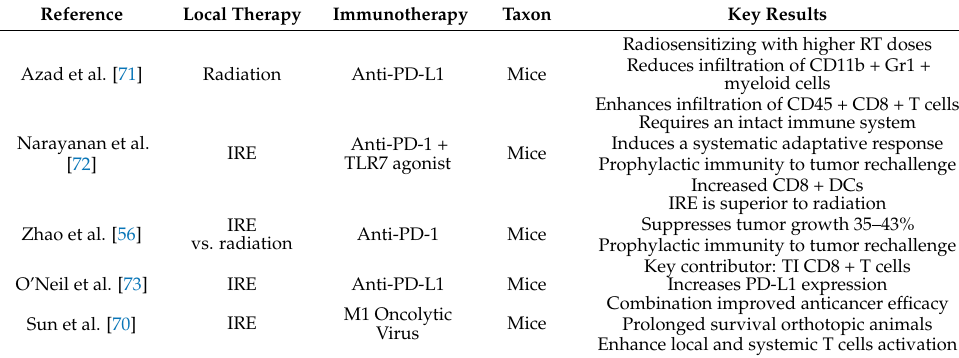
Table 1. Summary of in vitro and in vivo studies.